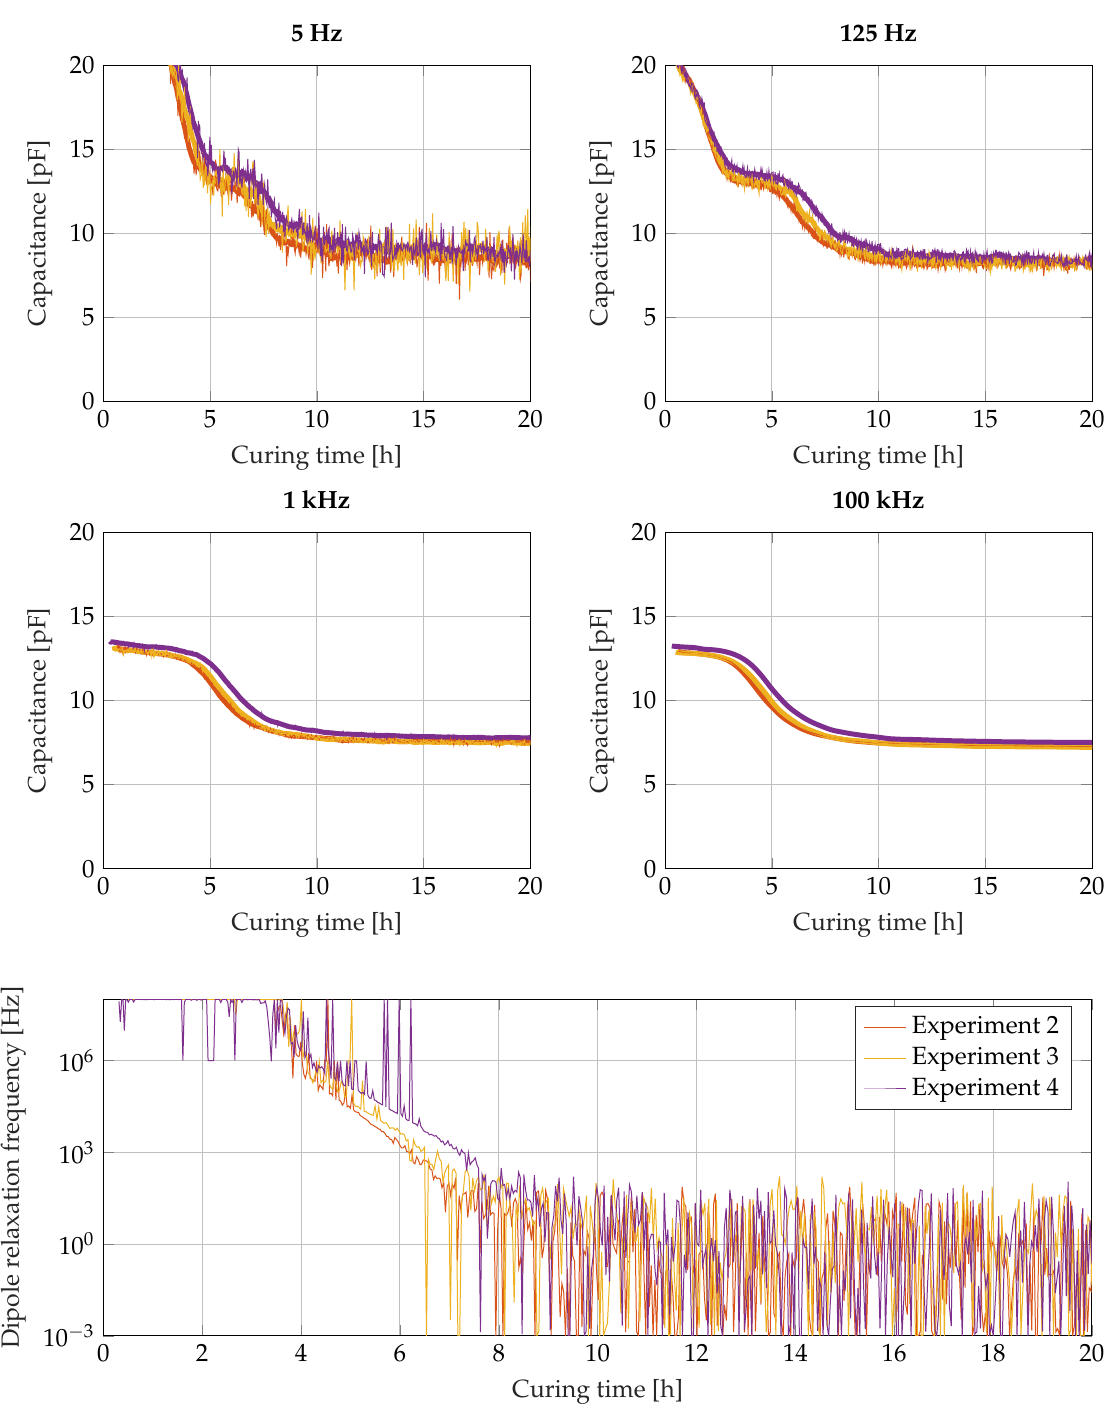
Figure 11. Changes in the permittivity caused by the curing reaction yield changes in the capacitance of interdigitated electrodes. The displayed capacitances were measured at 5Hz, 125Hz, 5kHz and 100kHz. In the bottom diagram, the course of the dipole relaxation frequency f CC is